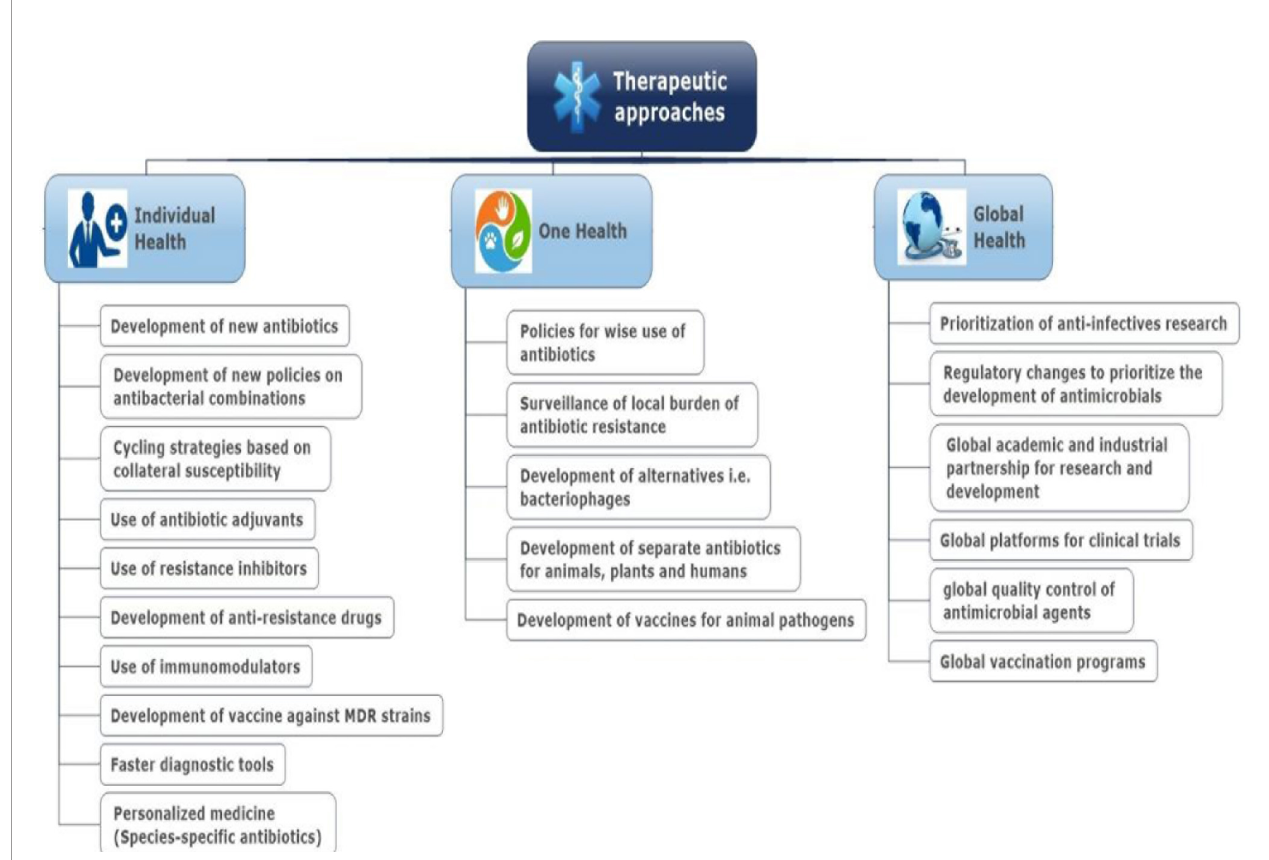
FIGURE 4 | Therapeutic approaches to reduce the burden of antibiotic